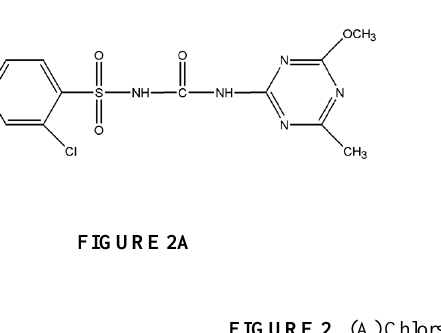
FIGURE 2 . (A) Chlorsulfuron; (B)